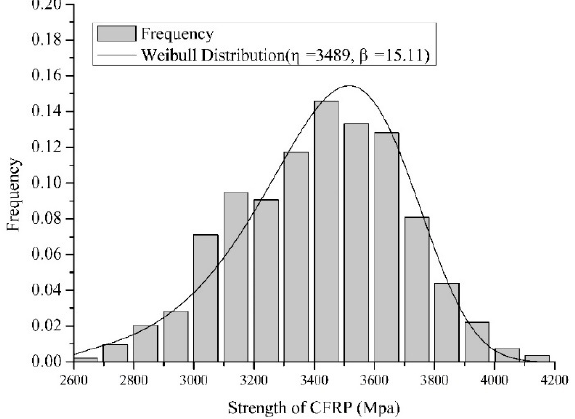
Figure 11. Comparison of the histogram and PDF of the 10-element parallel system.